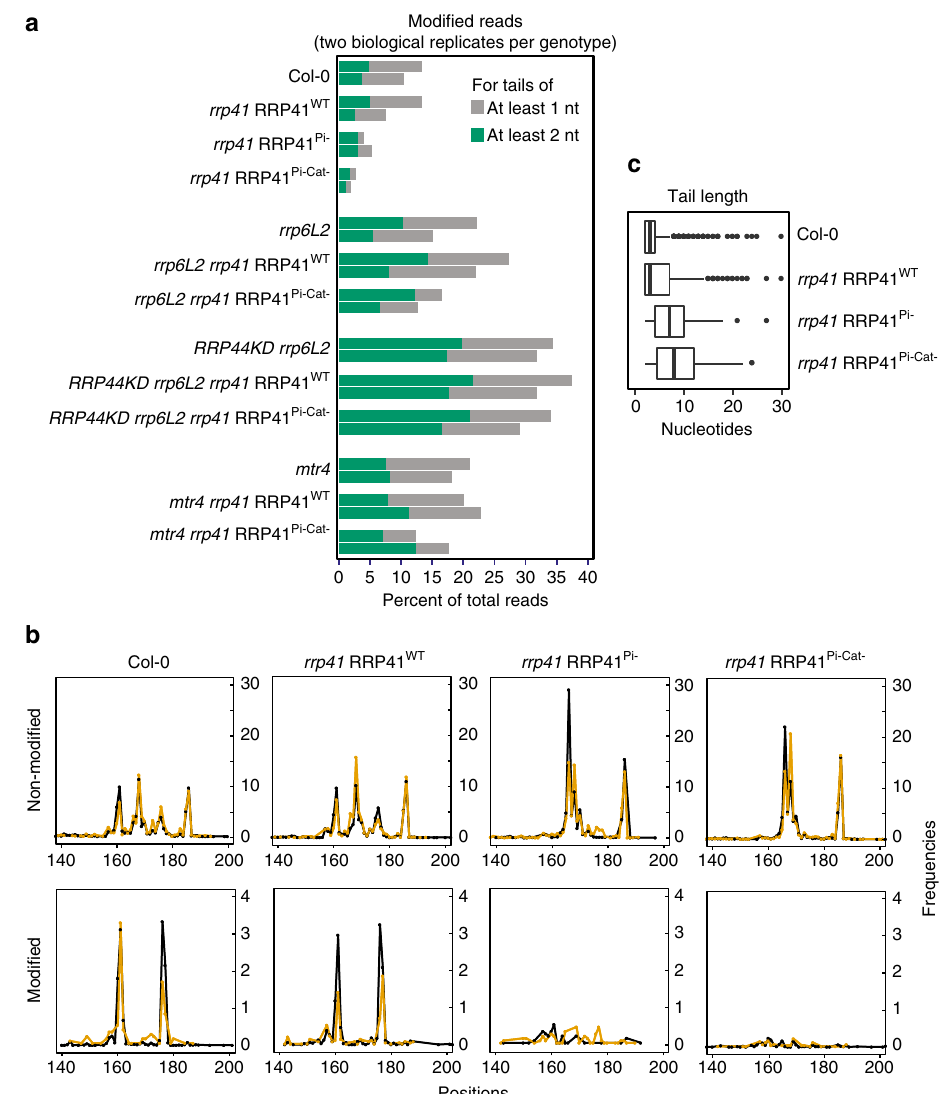
Fig. 4 Impact of Exo9 activity on the tailing of 5 ′ ETS degradation intermediates. a Exo9 inactivation results in reduced RNA tailing. The proportion of reads corresponding to 5 ′ ETS degradation intermediates modi fi ed by nucleotide additions is shown in gray (from 1 to 30 nt) or green (from 2 to 30 nt) for two biological replicates. b Nucleotides are only added to speci fi c P-P1 degradation intermediates. Reads corresponding to non-modi fi ed or modi fi ed P-P1 intermediates were split to generate the pro fi les shown as upper and lower panels, respectively. Two independent biological replicates are shown as black and orange lines. c Increase of tail length due to the inactivation of Exo9 ’ s activity. Box plot representation of tail lengths in nucleotides. The median is indicated by the black bars, the fi rst and third quartiles by the box edges, the interquartile range by thin bars, the outliers by dots and the data range (except outliers) is shown by